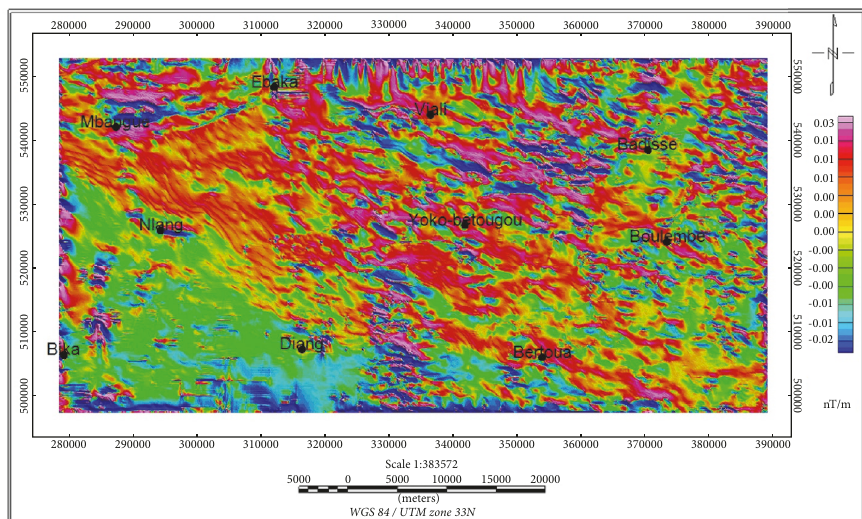
Figure 4: Horizontal gradient